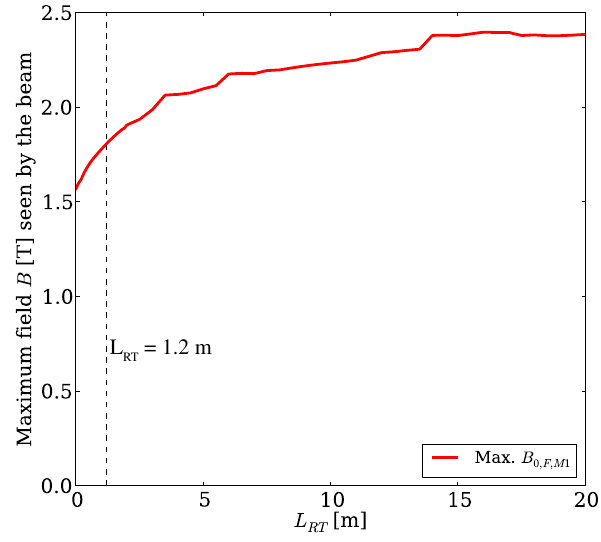
FIG. 13. The field seen by the highest energy orbit particle for the strongest magnet ( F M 1 ) in the matching cells before the long straight sections. The field increases into the superconducting region above 1.8 T after around 1.2 m of magnet-free straight is added to the symmetric ring.